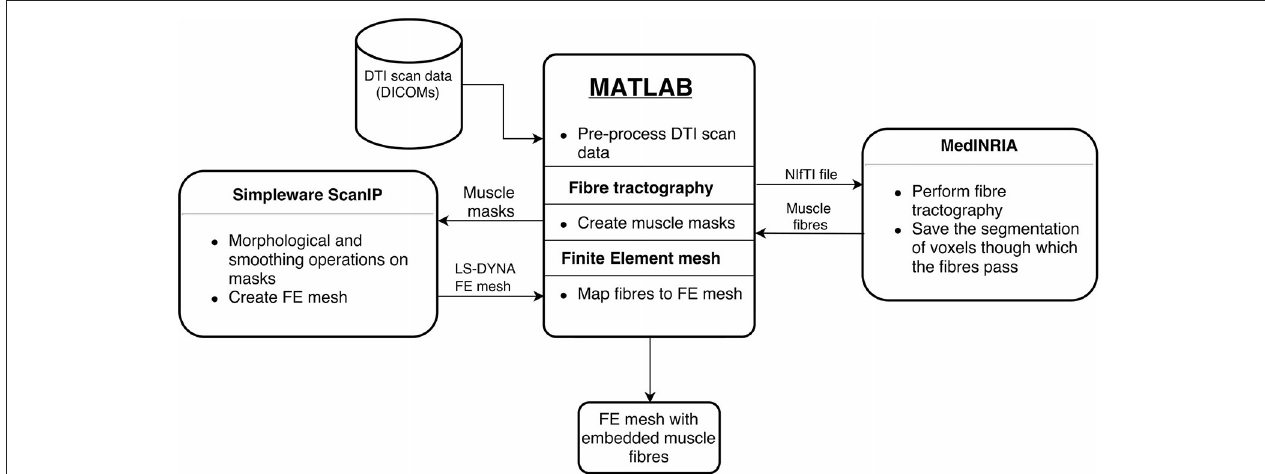
FIGURE 4 | Overview of implemented workflow. The proposed workflow that converts the DT-MRI scans into patient-specific residual limb model is illustrated here. MATLAB handles data processing and transfer between the various software tools. Fibre tracking is done using MedINRIA. Binary muscle masks are created from the voxel segmentation data, which are loaded into Simpleware ScanIP. After image processing in ScanIP, the FE mesh is generated with the ScanIP + FE module. Finally, the extracted fibres are embedded into the FE